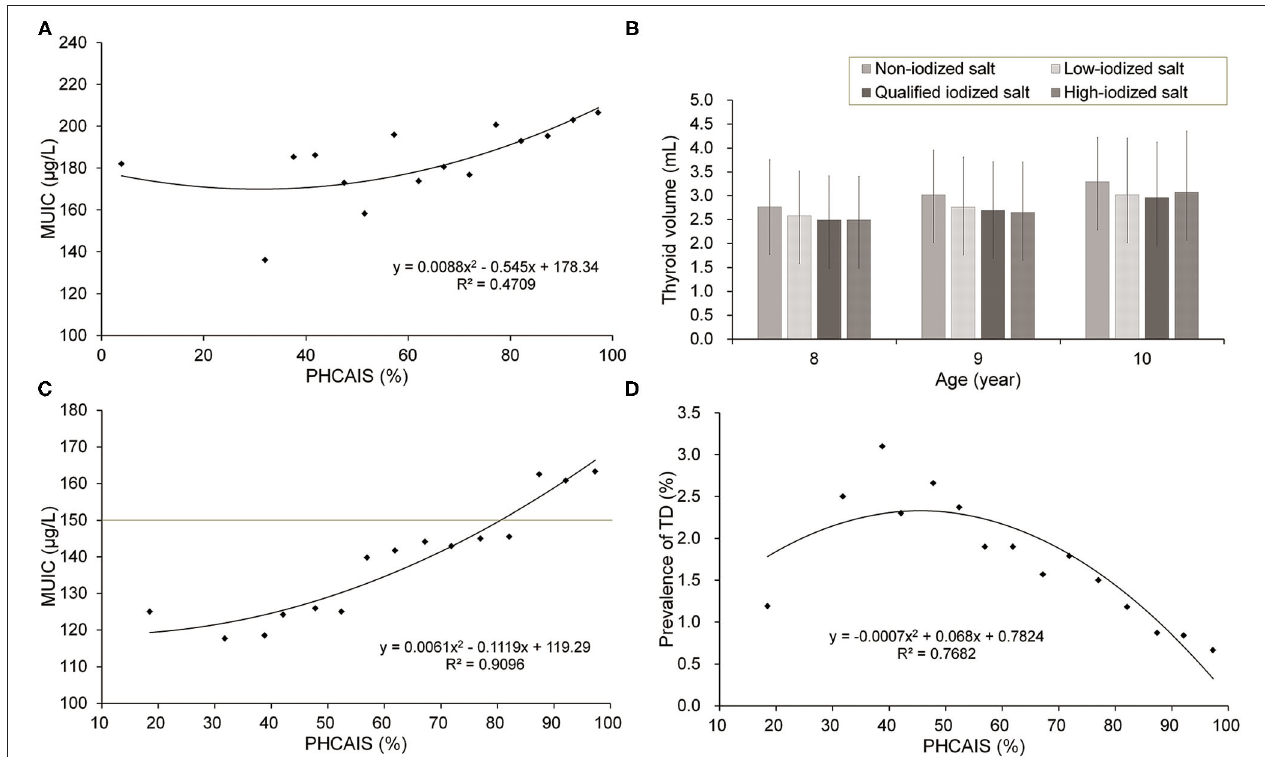
FIGURE 1 | The influence of iodized salt on thyroid disease and iodine nutrition. MUIC, median urine iodine concentration; PHCAIS, proportion of households consuming adequately iodized salt; TD, thyroid disease. (A,B) children and (C,D) pregnant women. p < 0.0001 for trend in all 3 age groups in (B) .